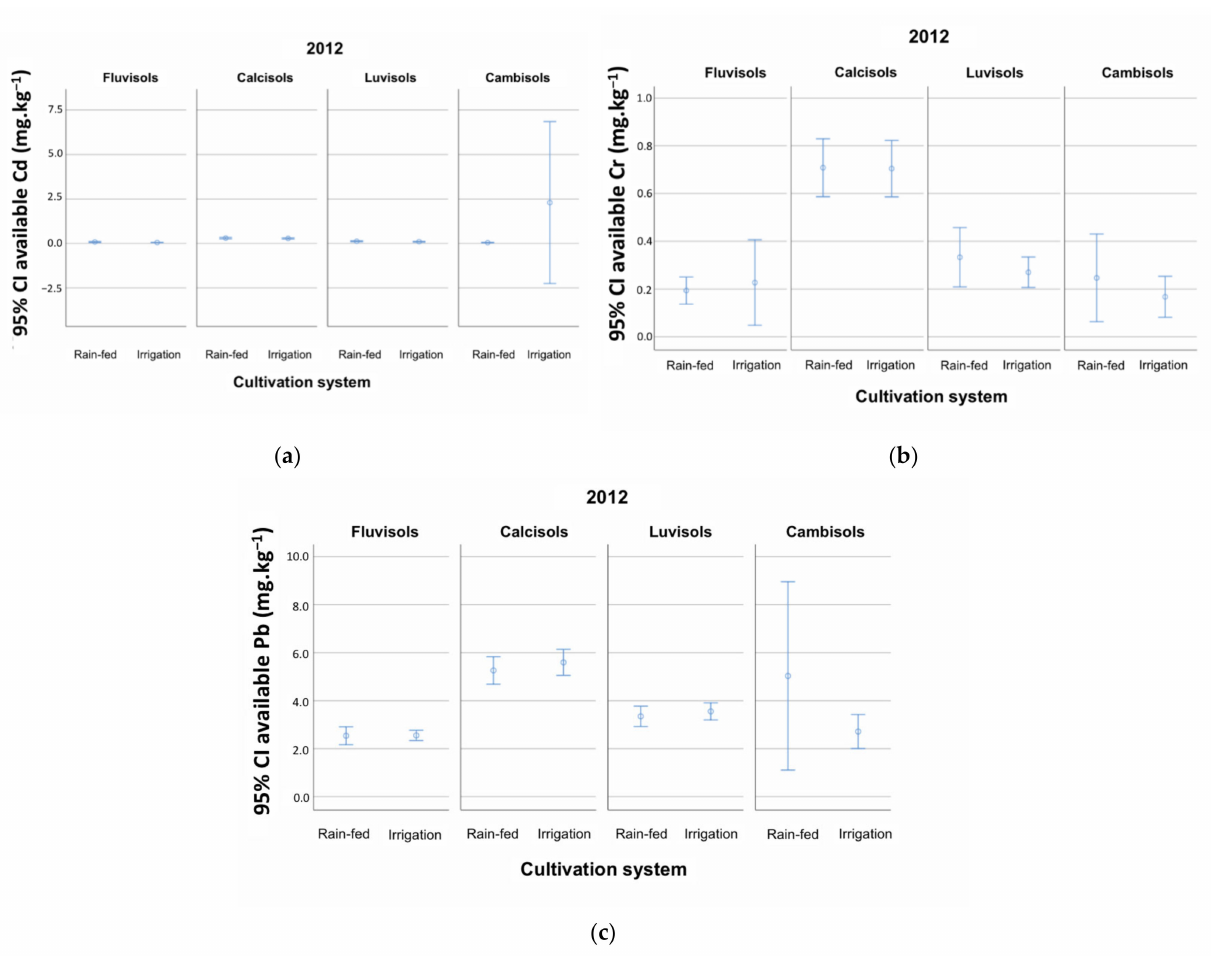
Figure 2. Error bars for the sample year 2012 by RSG for the available ( a ) Cd, ( b ) Cr, and ( c )